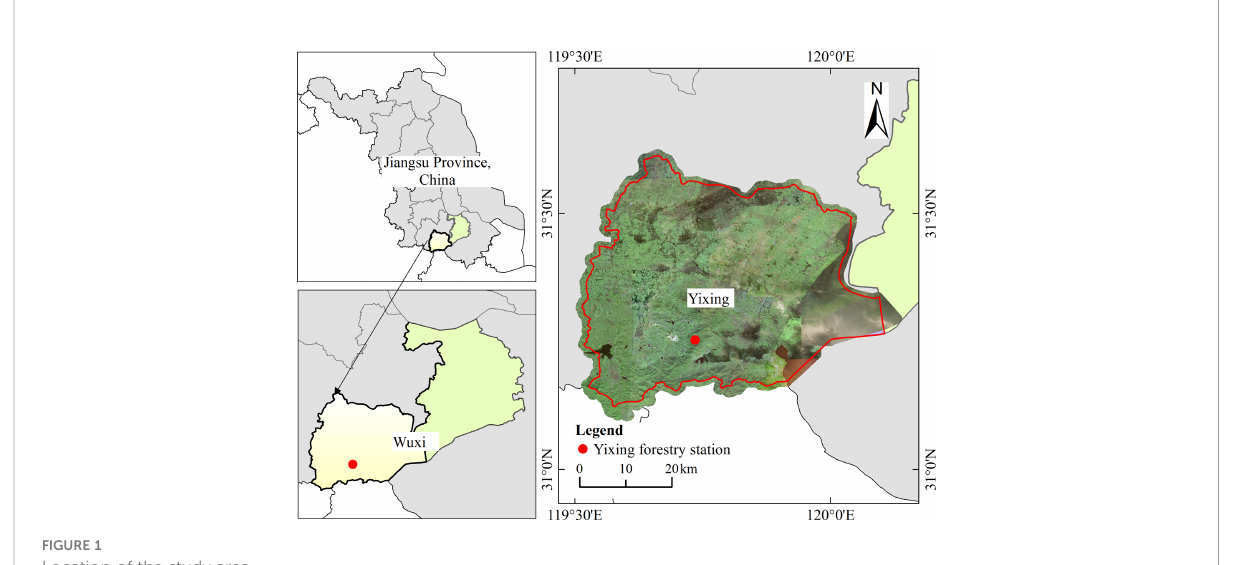
FIGURE 1 Location of the study